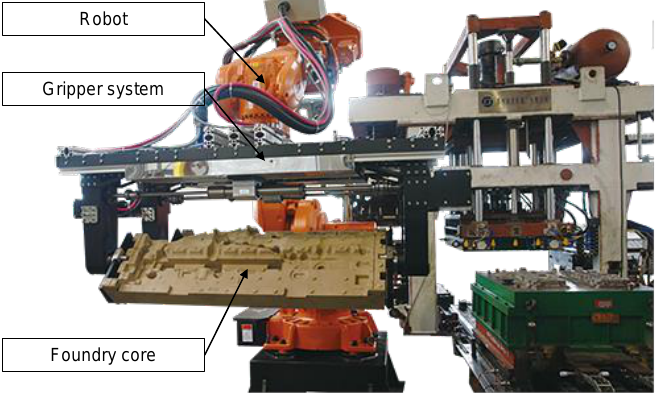
Figure 1. Core handling with a robot [8]. The design of the gripper and the locations of contact with the core determine the stresses in the